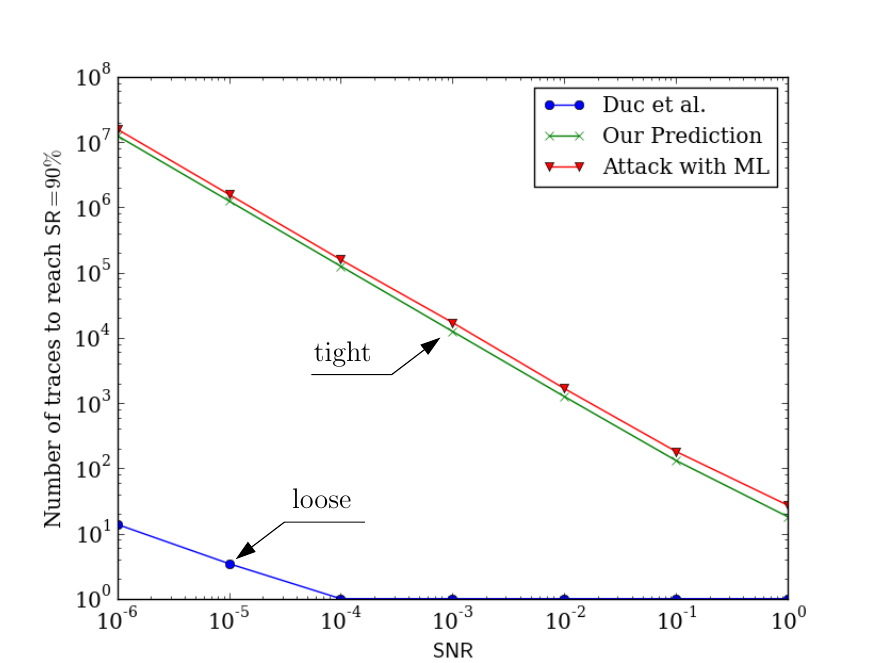
Figure 8: Comparison of our prediction with Duc’s